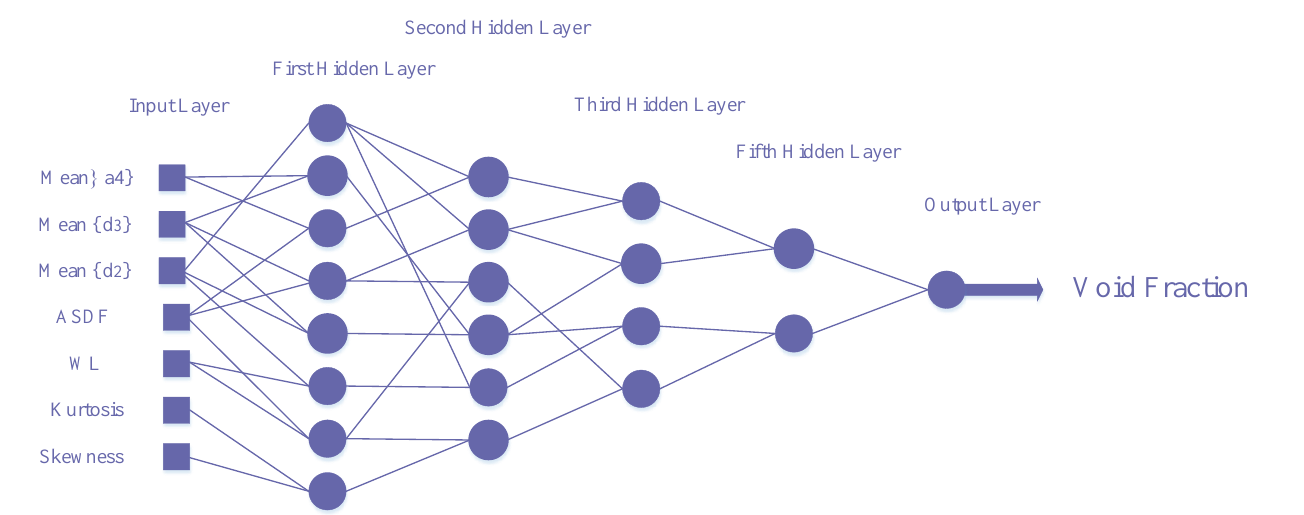
Figure 9. The structure of the trained GMDH neural network. A pair of regression and error histogram diagrams depicting the network’s perfor- mance throughout training and testing datasets are shown in Figure 10. The red circles in the regression diagram represent the network’s output values, while the blue line represents the expected output. Matching both of them with each other indicates high accuracy in neural network prediction. The distribution of the error value is graphically represented in the error histogram diagram. The MSE and RMSE were computed for both the training and testing data. The maximum MSE and RMSE values are, respectively, 0.09 and 0.30. The diagnosis system presented in this study was compared with previous studies in Table 1.